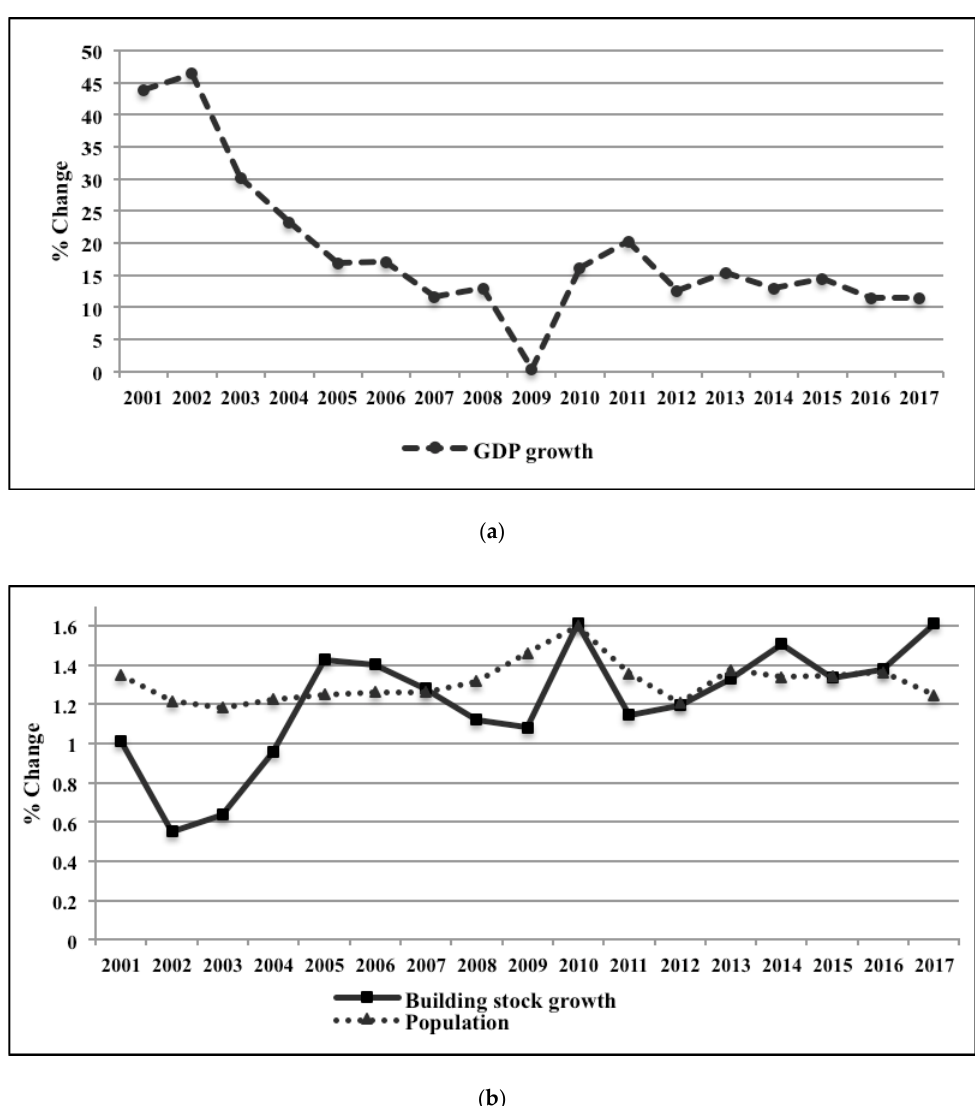
Figure 2. Comparison of GDP ( a ), building (residential, commercial) stock, and population growth rate in Turkey ( b ), 2001–2017. Source: Turkstat [55,59] Statistical indicators.